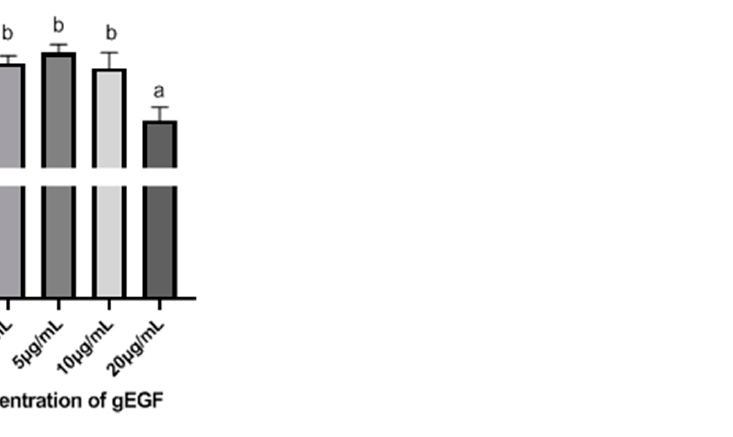
Figure 6. Effect of gEGF of various concentrations on UMNSAH/DF-1 cell proliferation. Values are given as mean ± SD ( n = 5). Bars with different letters (a and b) show the values with a significant difference ( p < 0.05).